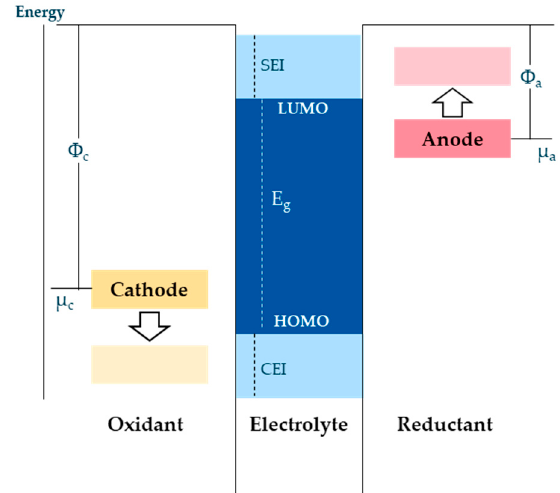
Figure 4. Description of the electrolyte homo/lumo limits (authors illustration according to [33]) .